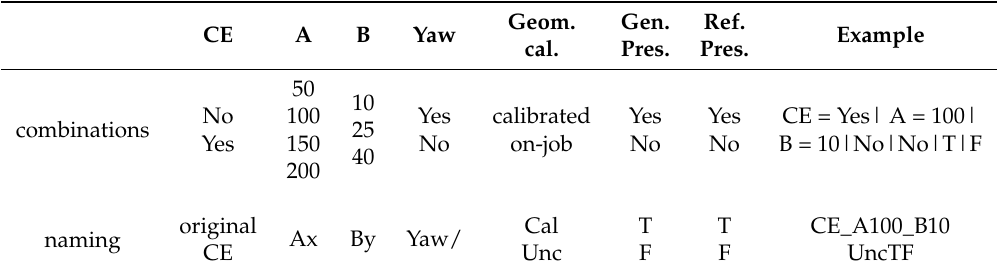
Table 1. 156 combinations of image alignment factors and their corresponding name in the following text. Geom.cal. = geometric camera calibration, Gen.Pres. = Generic pre-selection, Ref.Pres =